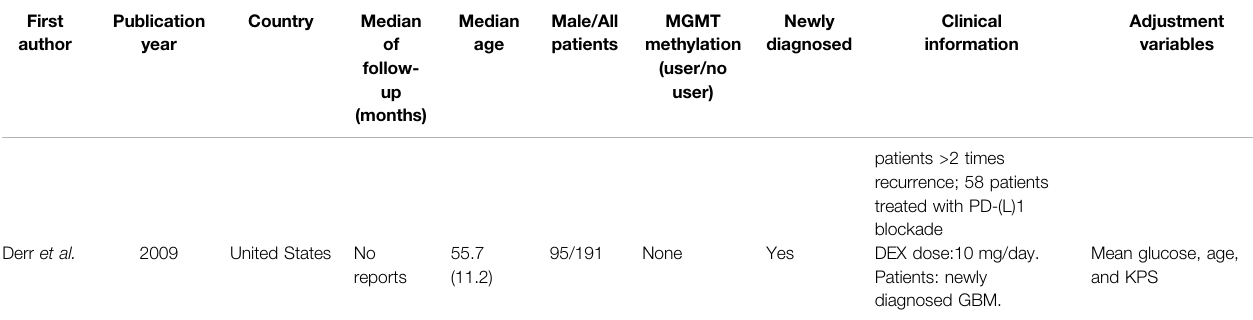
TABLE 1 | ( Continued ) The main characteristics of included studies.